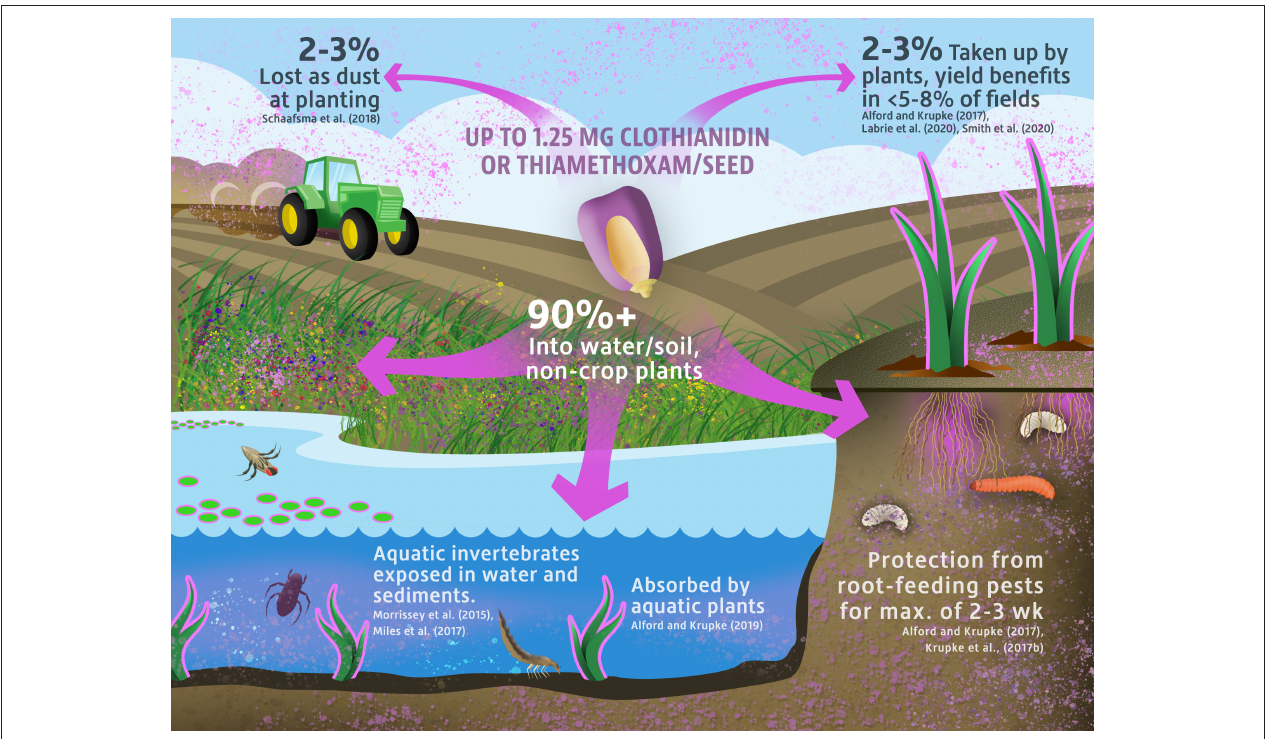
FIGURE 1 | A schematic representation of the environmental fate and transport routes of neonicotinoid active ingredients applied to crop